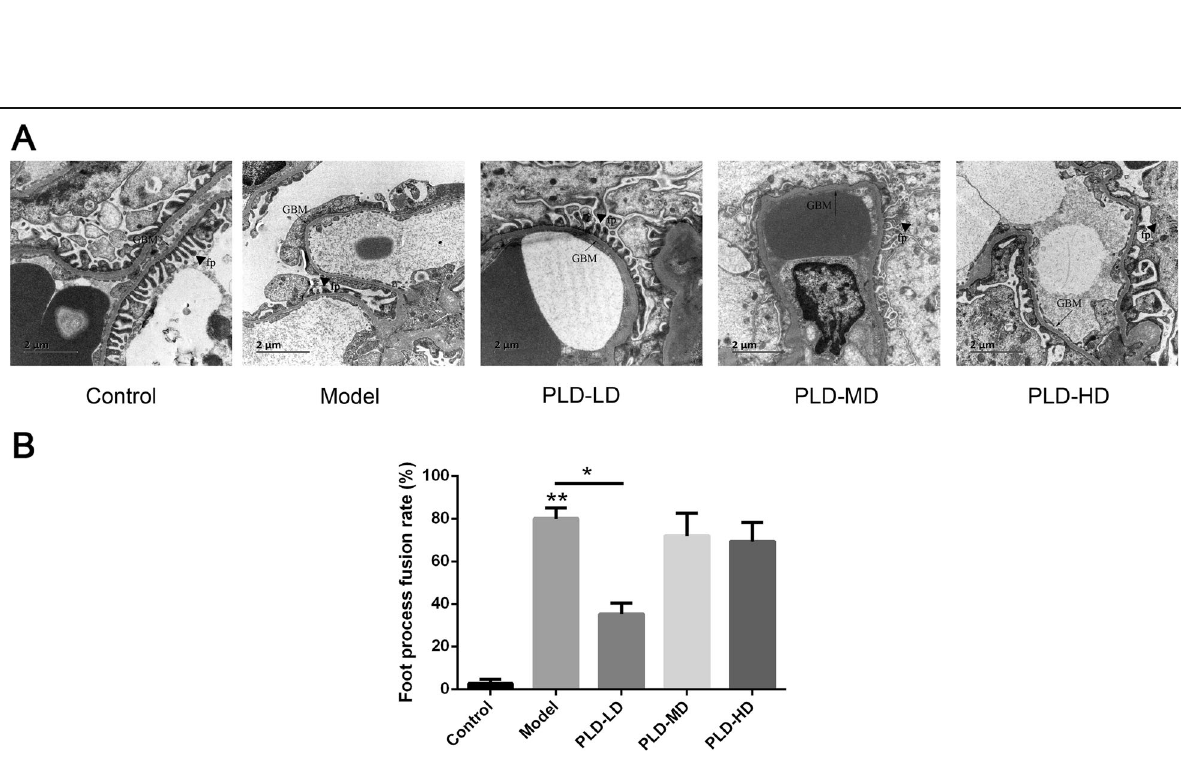
Fig. 4 Analysis of renal pathology by TEM. a Representative micrographs in each group are shown. GBM, glomerular basement membrane (black arrow); fp, podocyte foot process (black triangle). Scale bar 2 μ m (bottom left). Original magnification × 10,000, n = 6 animals in each group. b The foot fusion rate of each group. Data are presented as the mean ± SD. * p < 0.05; ** p <